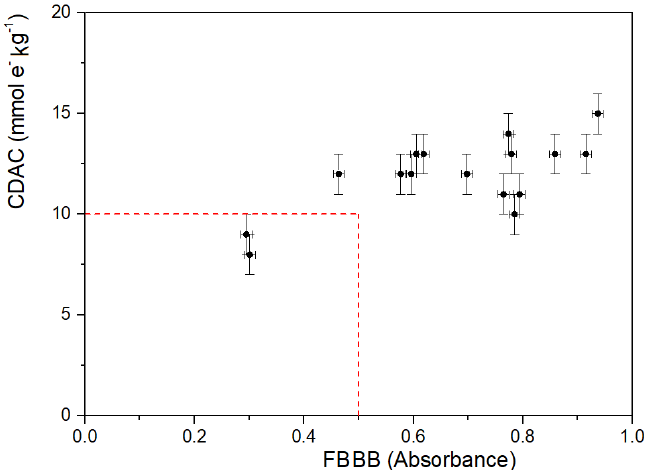
Figure 4. Plot of coulometrically determined antioxidant capacity (CDAC) values vs. Fast Blue BB (FBBB) absorbance. Values are means of three replicates. Error bars represent the estimated precision as standard deviation.